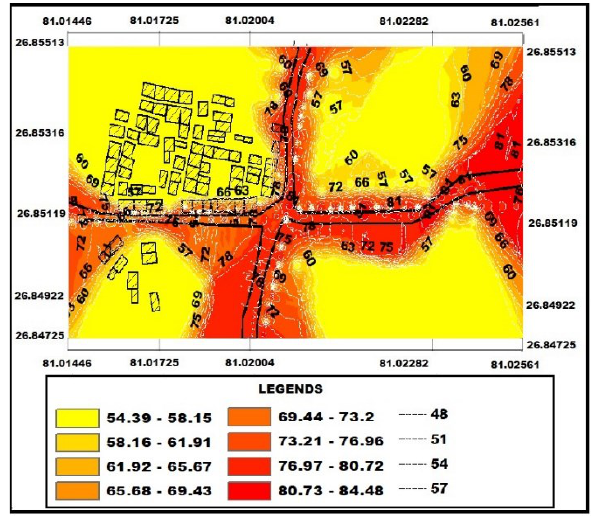
Figure 6. Noise level map of Haniman crossing for organized road for morning time.